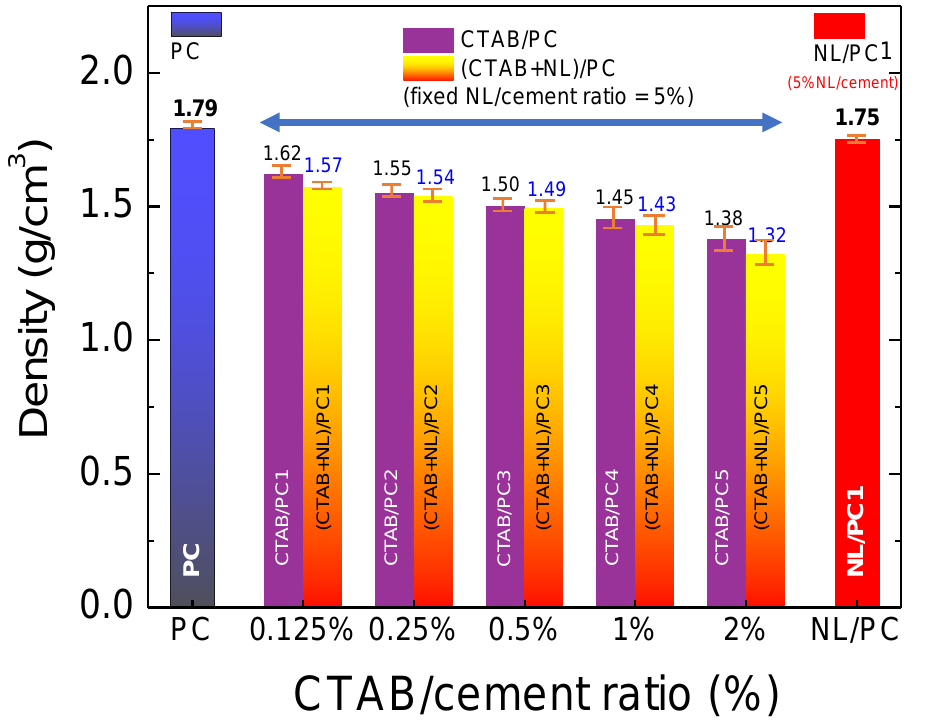
Figure 3. Bulk densities of CTAB/PC and (CTAB + NL)/PC (fixed NL/cement ratio = 5%) composites with different CTAB/cement ratios (0.125–2%) compared to those of the control PC and NL/PC1 composite.